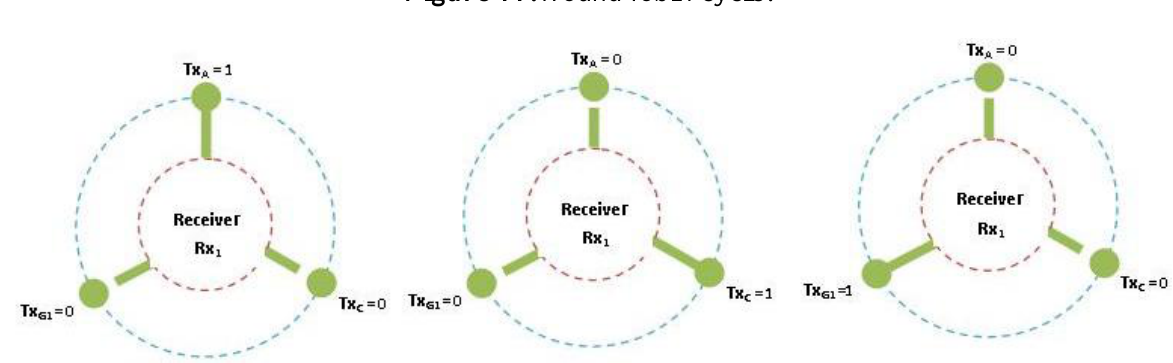
Figure 11. Round robin